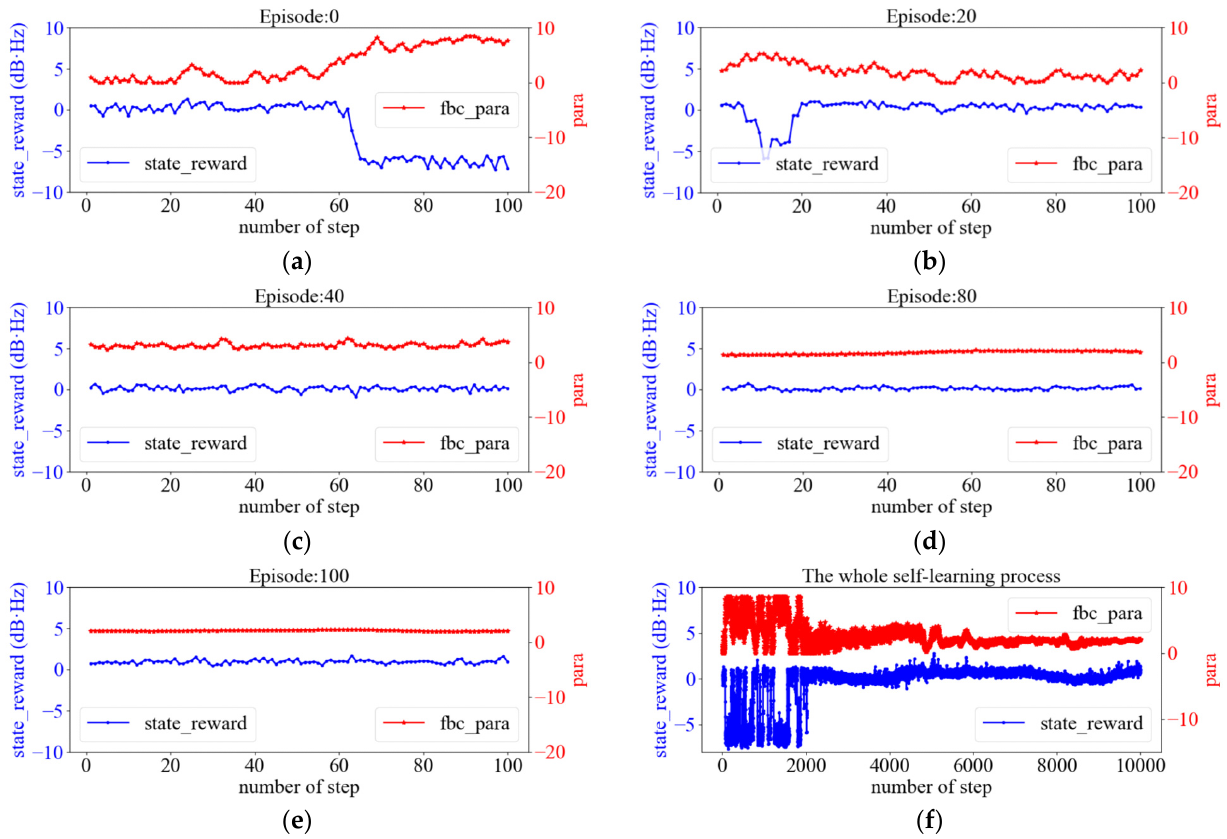
Figure 11f reflects the convergence range of the FBC parameter at [2, 3].